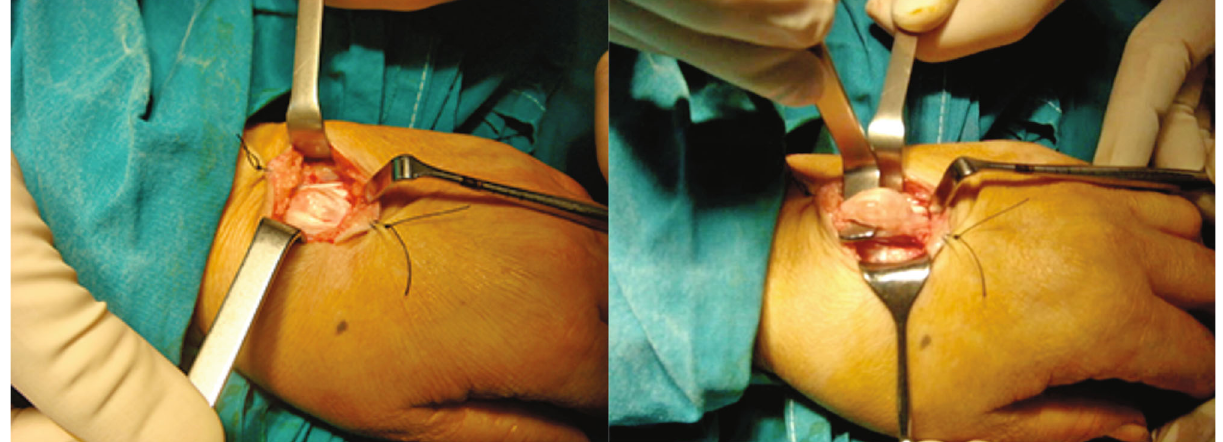
Figure 1: Intraoperative picture showing intratendinous lesion of the EDC tendon.